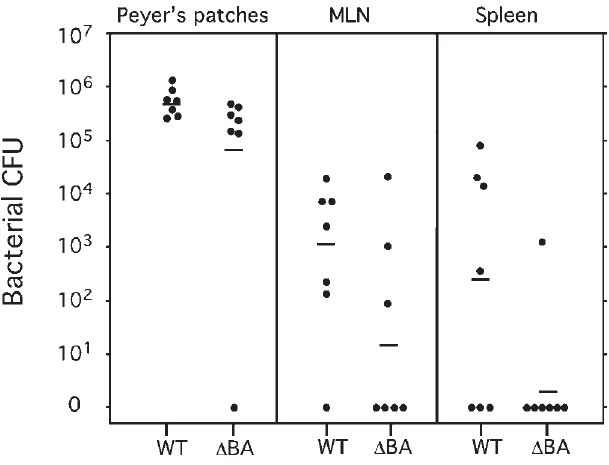
Figure 3. Wild-Type and D BA Strains Display Different Patterns of Tissue Colonization Groups of seven mice per strain were infected via the orogastric route with 2 3 10 9 cells and sacrificed on day 4 of infection. Harvested tissues were processed for CFU determination as described in Materials and Methods. Each symbol represents the CFU contained in the indicated tissue sample from one mouse. Data were analyzed by Student t- test in order to determine statistical significance of CFU counts in Peyer’s Patches ( p , 0.051), MLN ( p , 0.271), and spleen ( p , 0.044). The smpB- ssrA mutant was found to be able to reach extra-intestinal sites but unable to proliferate efficiently within the MLN and spleen. DOI: